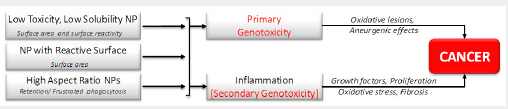
Diagram showing the potential processes that might be involved in MNP carcinogenesis. Biologically effective doses are shown below each particle type on the left and potentially important pathobiological processes are shown around the arrows leading to cancer on the